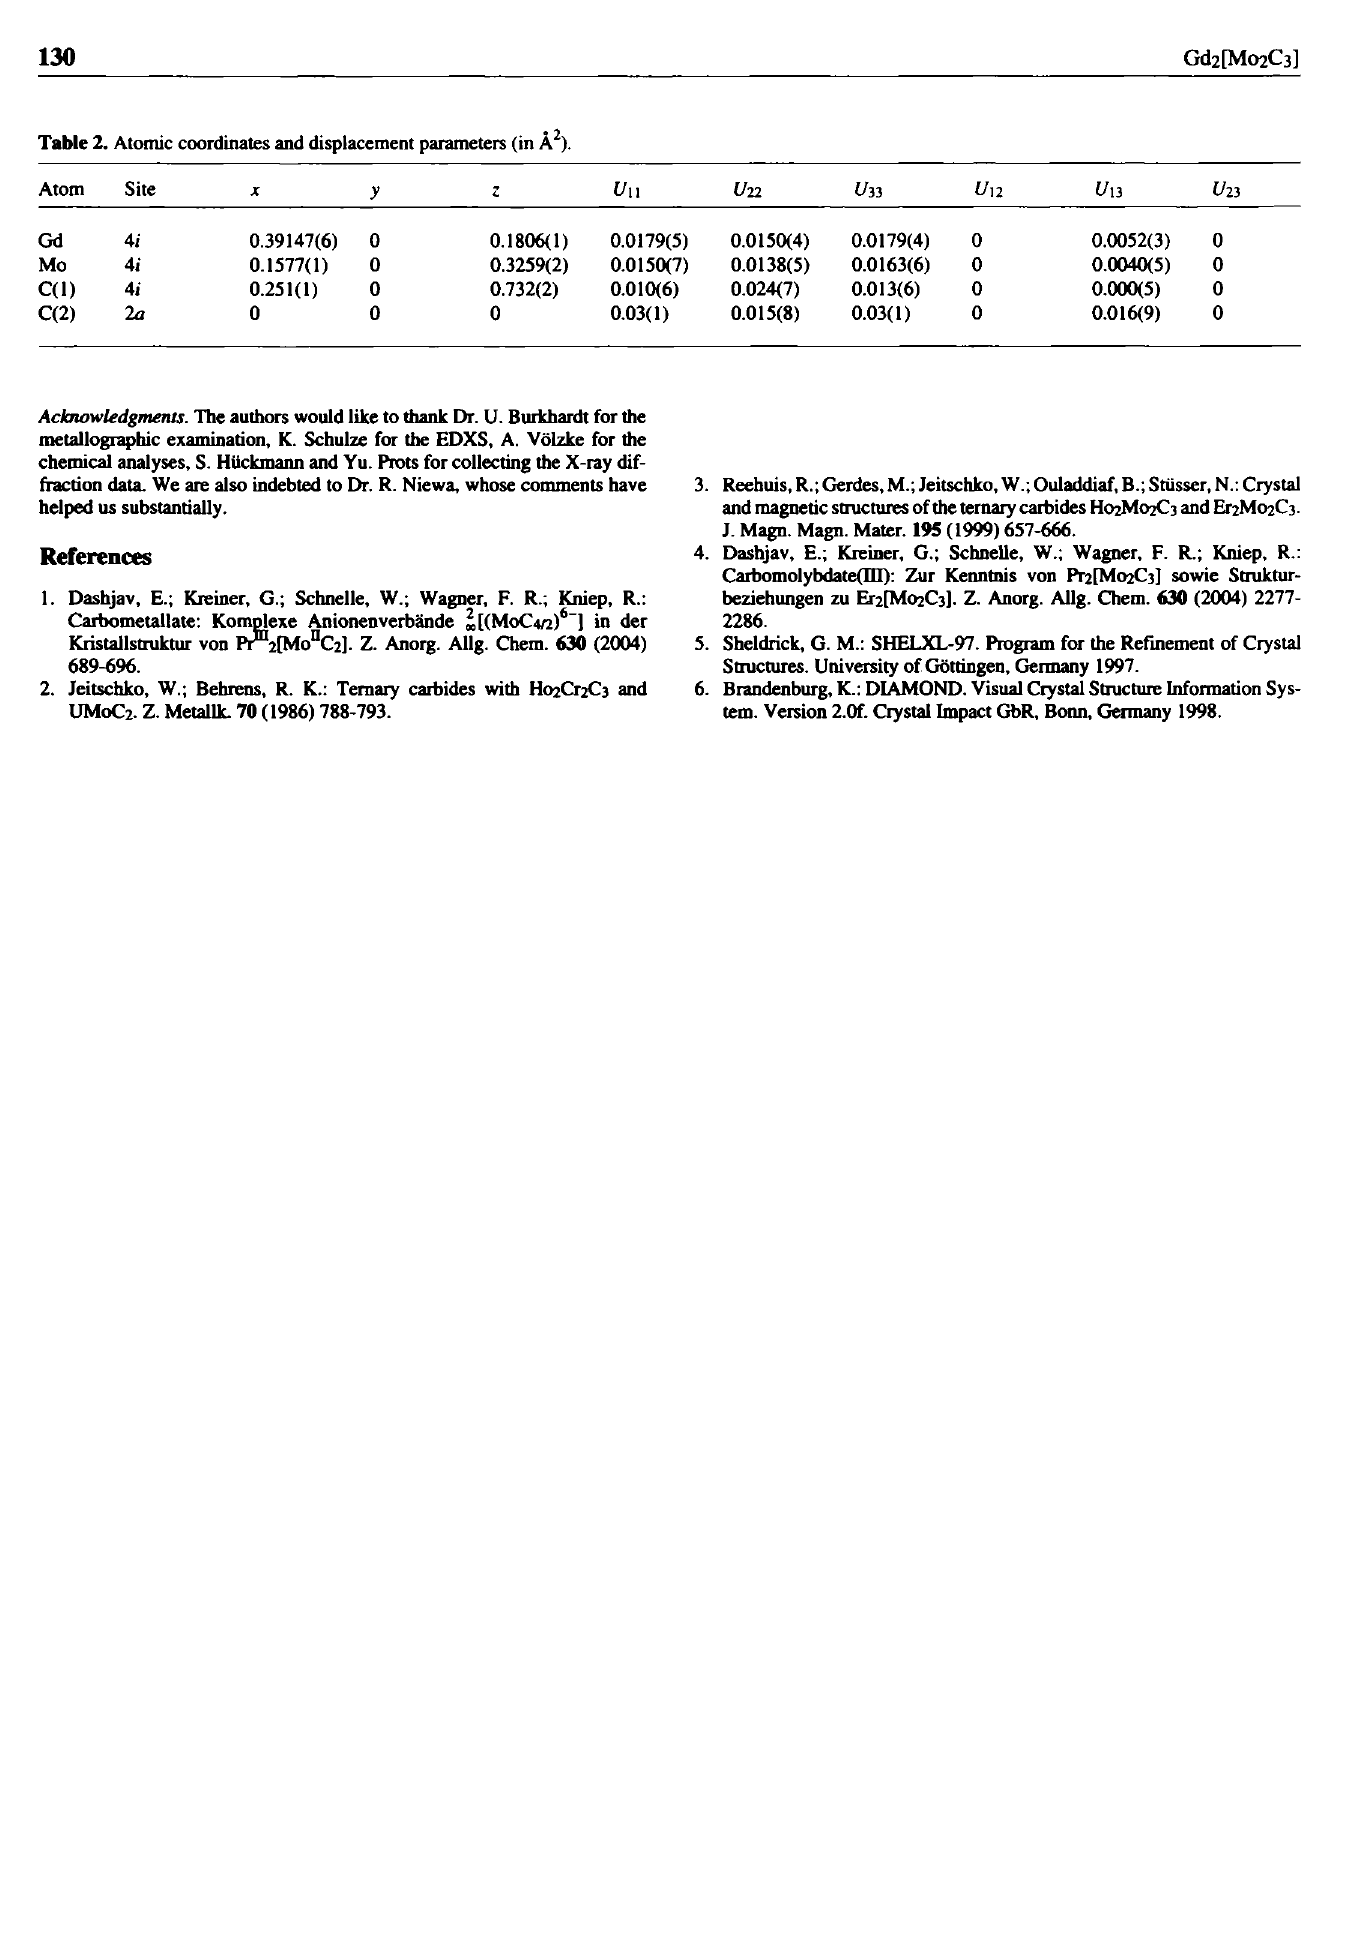
Table 2. Atomic coordinates and displacement parameters (in A 2